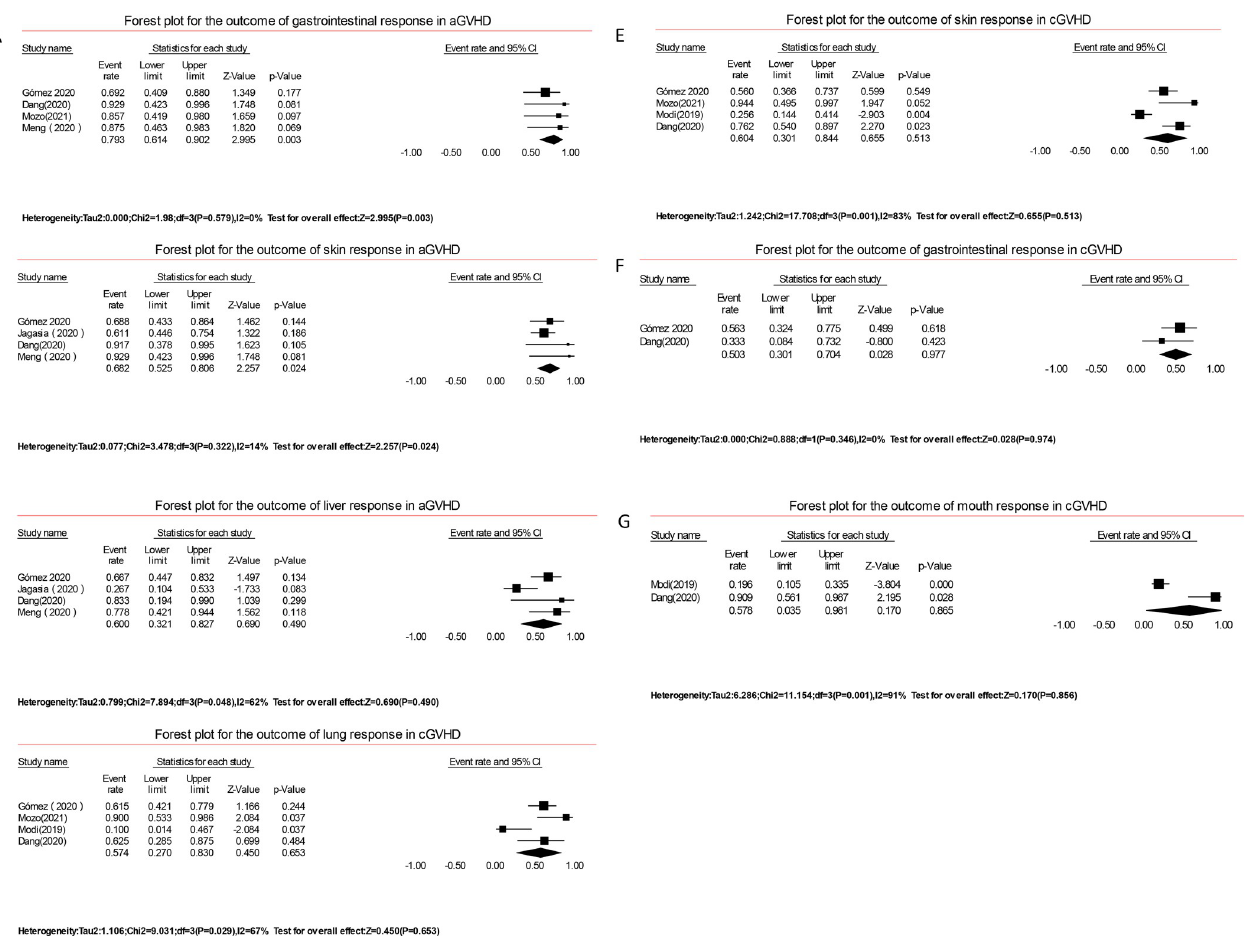
Fig 5. Forest plots of organ specific response (skin, liver, gastrointestinal, lung and